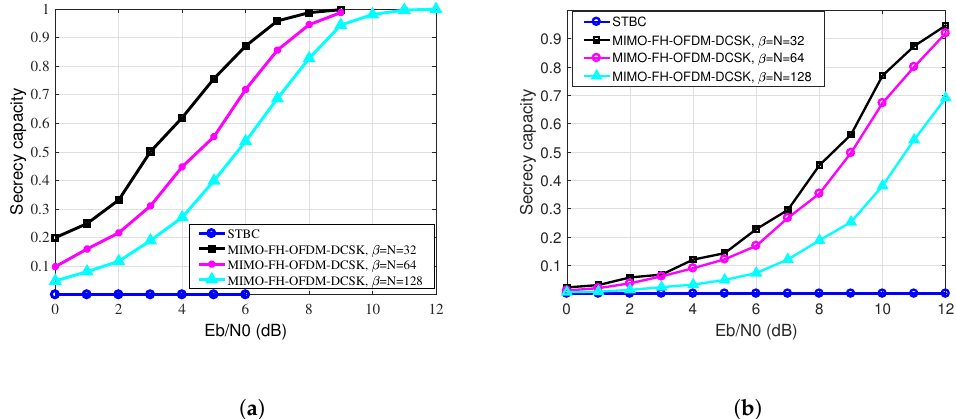
Figure 7. The secrecy capacity comparison between the proposed system and the benchmark scheme (STBC). ( a ) AWGM channel; ( b ) Rayleigh channel. Table 1. Secrecy capacity comparison between the proposed system and the benchmark scheme (STBC) in the AWGN channel.